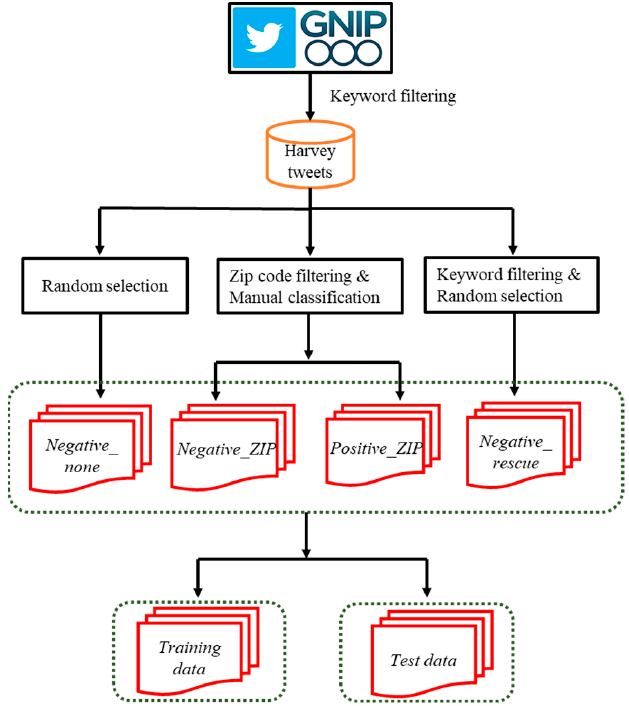
Figure 2. Workflow for preparing training and test data for machine learning models of rescue requests.